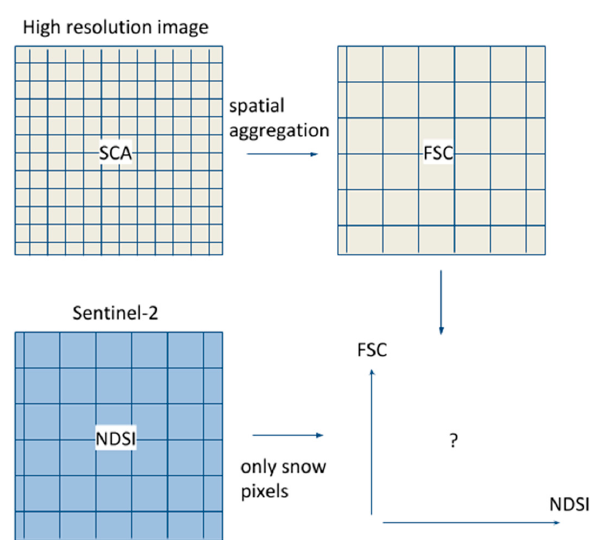
Figure 1. Schematic of the method used to determine the NDSI–FSC relationship. In this study the spatial aggregation was done using the average of all contributing pixels unless there was at least one no-data value. Then the FSC pixel was set to no-data. Remote Sens. 2020 , 12 , x FOR PEER REVIEW